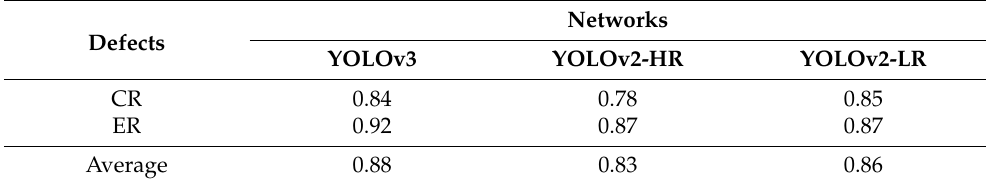
Table 1. Detection results of original YOLOv3 and YOLOv2.